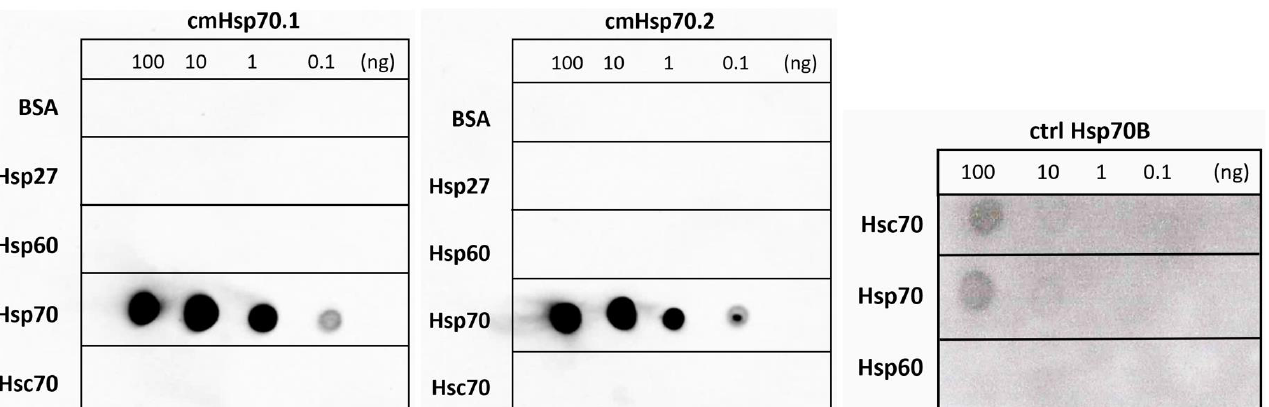
Figure 2. Western blot of recombinant Hsp70 protein and tumor cell lysates, flow cytometric analysis of membrane-bound Hsp70 on viable tumor cells, and dot blot analysis using BSA, recombinant Hsp27, Hsp60, Hsp70, Hsc70 as target proteins. ( a ) Hsp70 protein and lysates of tumor cells were subjected to an SDS gel and blots were stained with cmHsp70.1, cmHsp70.2, ctrl Hsp70A and ctrl Hsp70B antibodies. Representative immunoblots of recombinant Hsp70 (upper, 72 kDa) and tumor cell lysates (lower) representing Hsp70 (72 kDa), Hsc70 (73 kDa) and β -actin (40 kDa) as a loading control are shown. Molecular weight markers are indicating 70 kDa and 40 kDa. Detailed information about Western blot can be found at Supplementary Materials. ( b ) Detection of membrane-bound Hsp70 on A549, HCT116 cell lines by flow cytometry using the